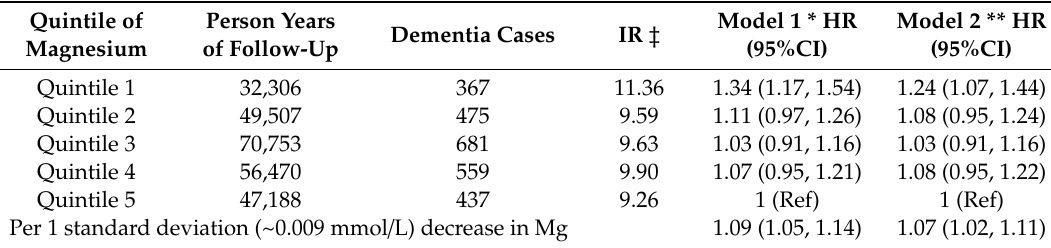
Table 2. Association of baseline magnesium with incident dementia, ARIC